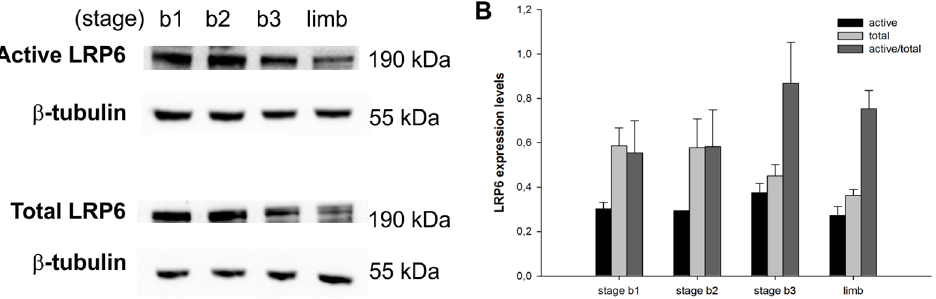
Figure 5. Activity of Wnt/ b -catenin pathway in the embryonic chick lung. (A) Western blot analysis of phospho-LRP6 (Ser1490) and total LRP6 in stage b1, b2 and b3 lungs, and stage 24 limb (as positive control). Control loading was performed using b -tubulin (55 kDa). Phospho-Ser1490 and total LRP6 correspond to 190 kDa. (B) Semi-quantitative analysis for phospho-Ser1490 and total LRP6. Results are presented as arbitrary units normalized for b - tubulin.